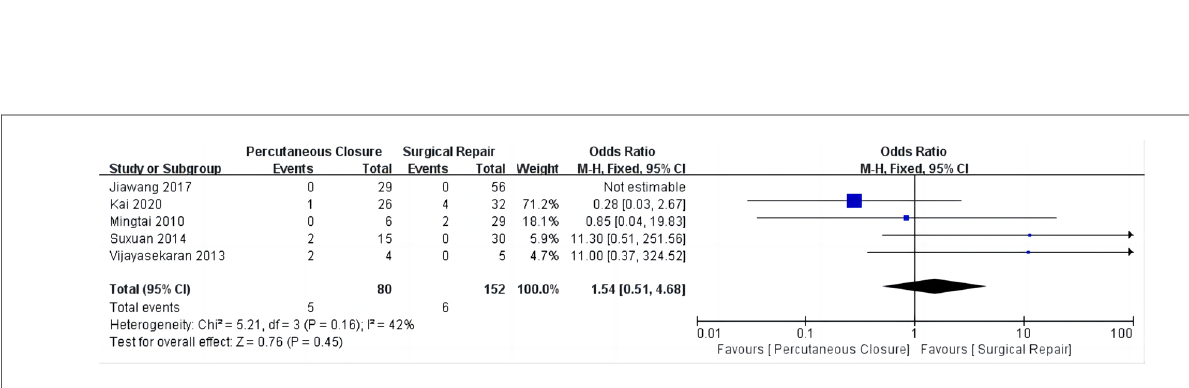
FIGURE 4 Comparing postoperative aortic regurgitation of percutaneous closure and surgical repair.